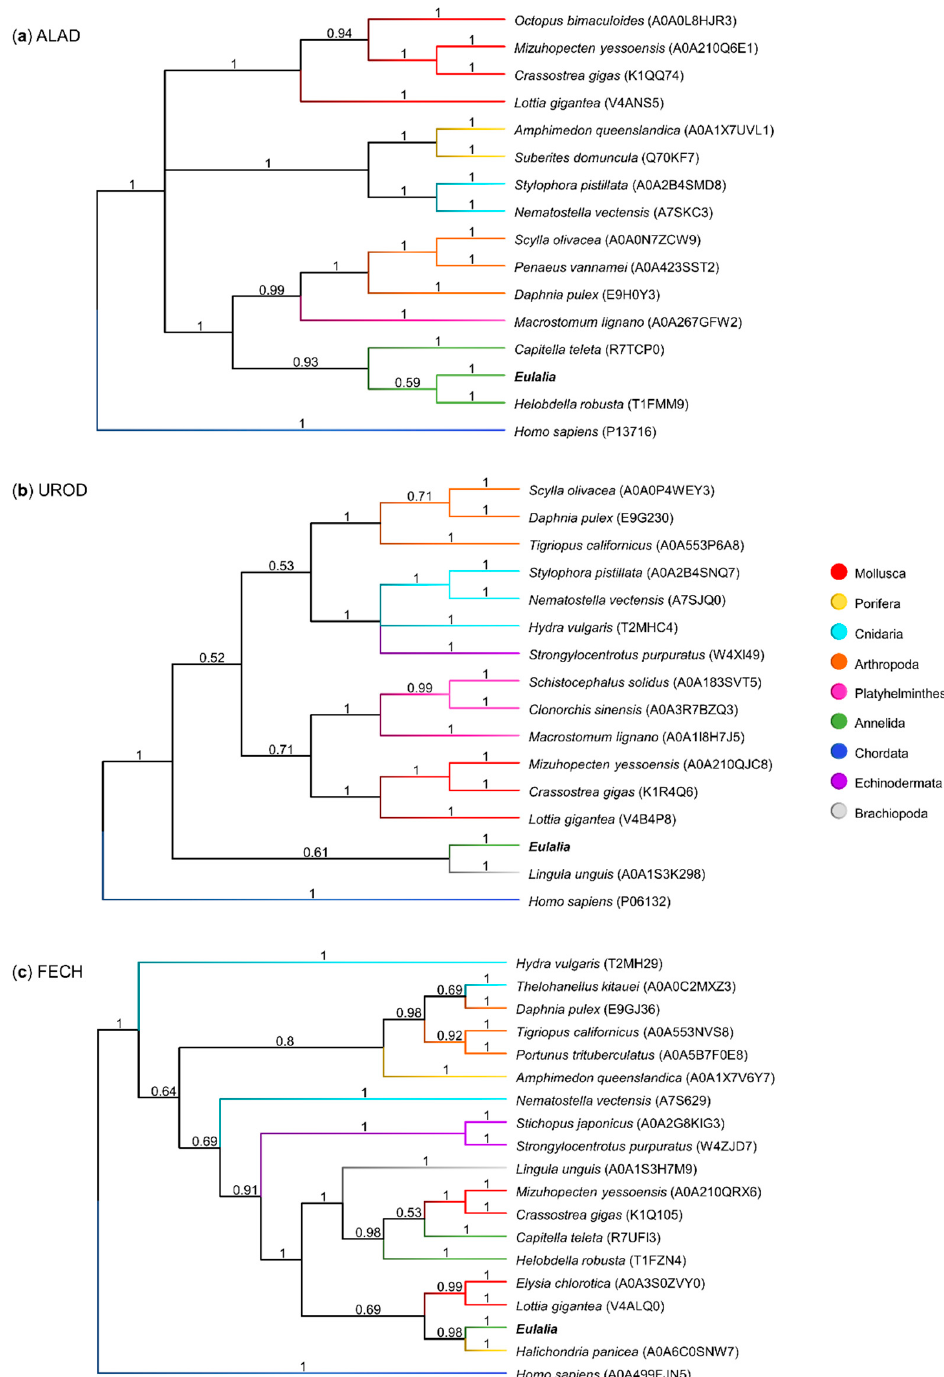
Figure 8. Phylogenetic trees comparing the sequences of three main heme biosynthesis proteins. Each dendrogram was created using the maximum likelihood method and an LG gamma distribution model (consensus tree obtained from 1,000,000 iterations). The sequences used were from Eulalia predicted transcriptome and Metazoa sequences from Uniprot for ( a ) ALAD, δ -aminolevulinic acid dehydratase; ( b ) UROD, uroporphyrinogen decarboxylase; and ( c ) FECH, ferroche- latase.